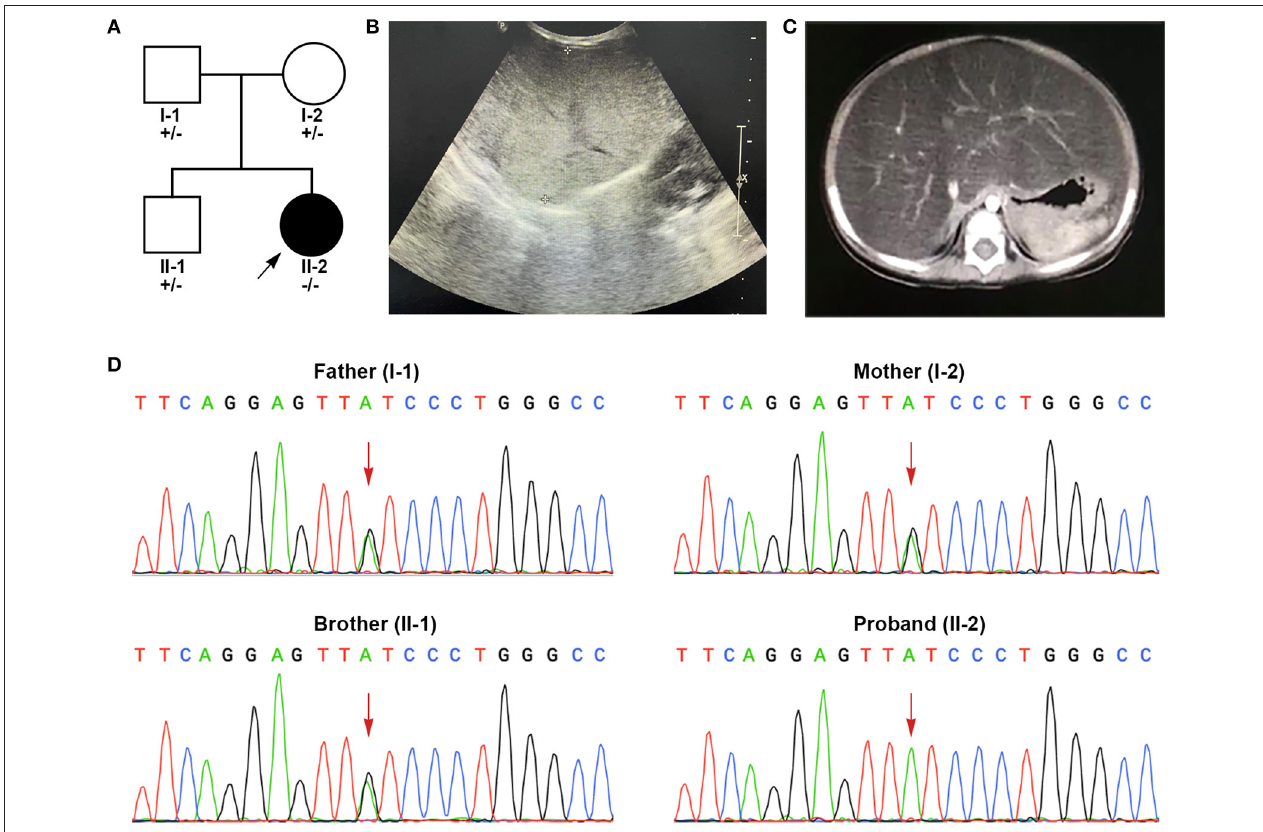
FIGURE 1 | Clinical features and genetic sequencing data of the patient. (A) The pedigree of the family. (B) B-mode ultrasound demonstrated diffuse hyperechogenicity of the liver with a fine granular pattern. (C) Contrast-enhanced CT scan of abdomen shows a significantly enlarged liver with fatty change. (D) Sanger sequencing shows that the patient harbored homozygous mutations (c.454C > T, p.Q152*) in exon 6. The patient’s parents and brother were all heterozygous for this